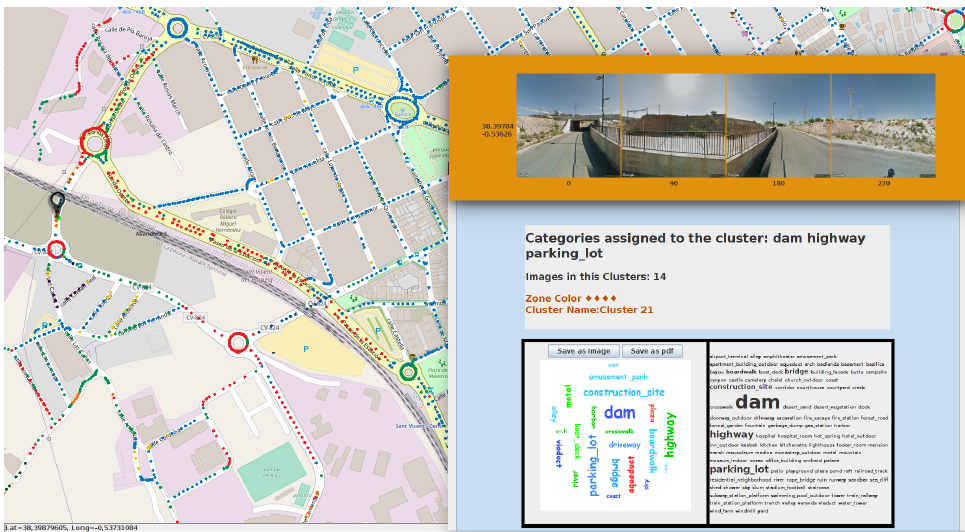
Figure 14. Failure case presented in the generated map; dam label occurrence in the middle of a